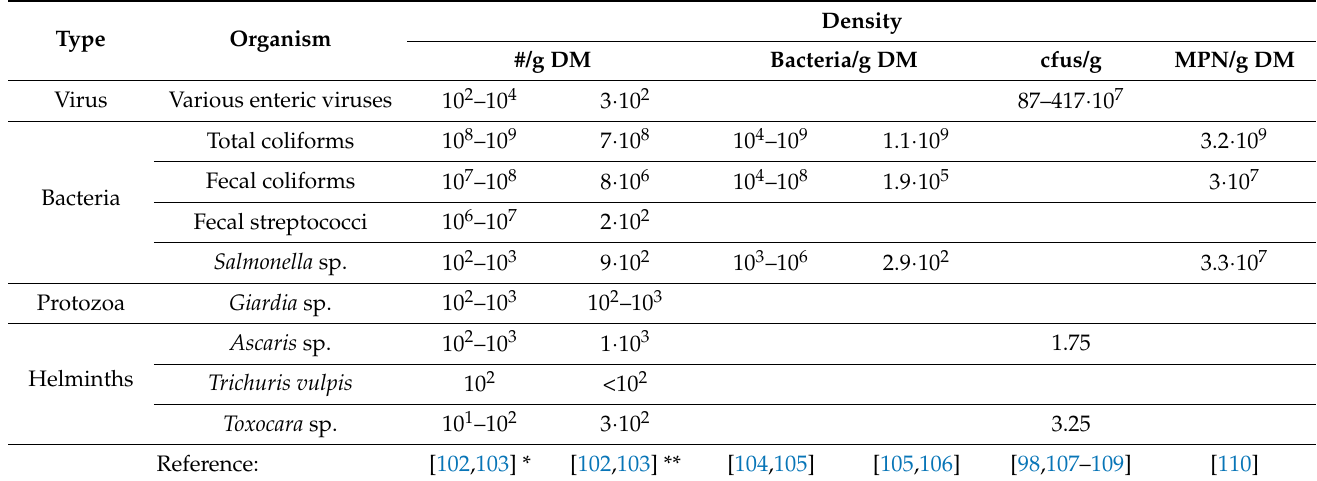
Table 3. Sanitary indicators for municipal sewage